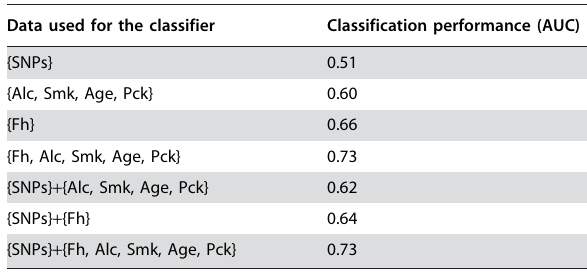
The classification algorithm is Support Vector Machines (SVM). Only SNPs selected by Recursive Feature Elimination (RFE) are used. The following abbreviations are used for variable names: Age (age at interview), Smk (tobacco use), Alc (alcohol consumption), Fh (family history of esophageal cancer), and Pck (consumption of pickled vegetables). The ‘‘ + ’’ symbol in the Data column denotes that the analysis was performed by ensembling